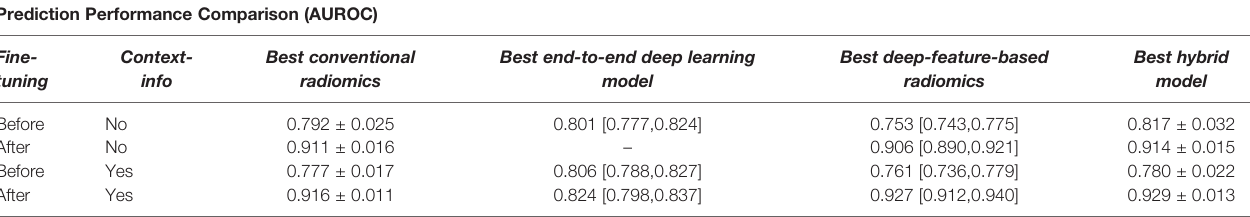
TABLE 5 | Comparing the prediction power of the employed